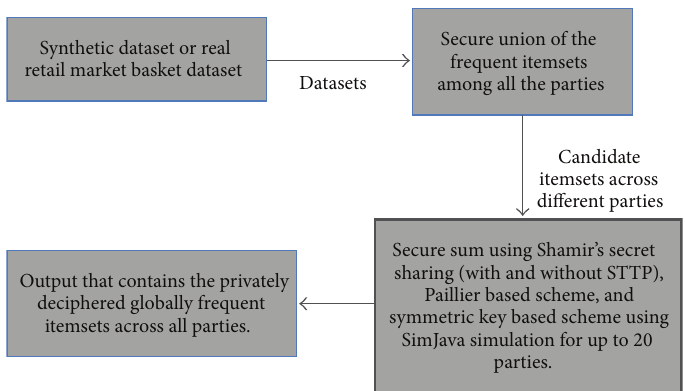
Figure 3: Methodology of evaluation for the proposed algorithms in a PPDFIM setup.